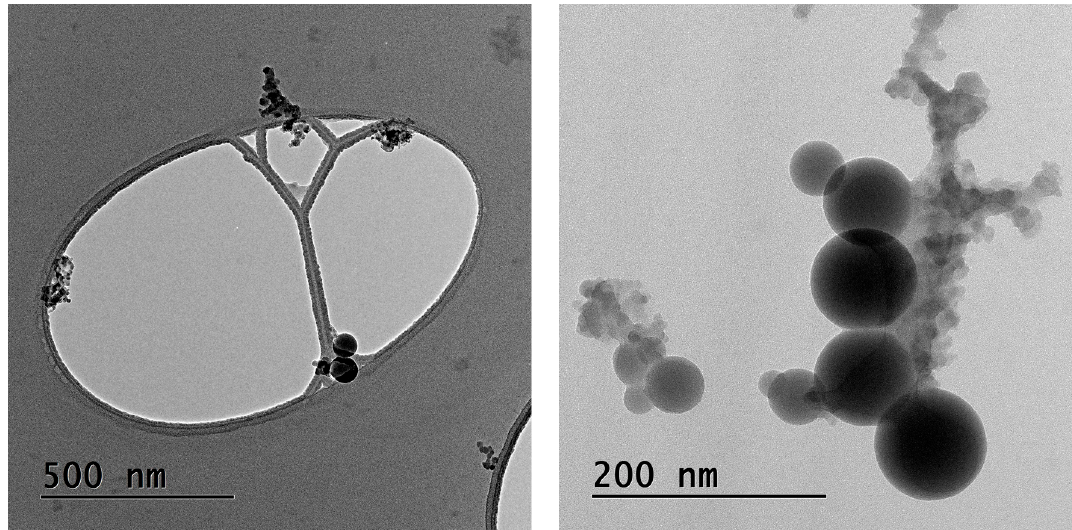
Figure 5. Transmission electron micrographs of ultrafine PM collected by the ELPI.